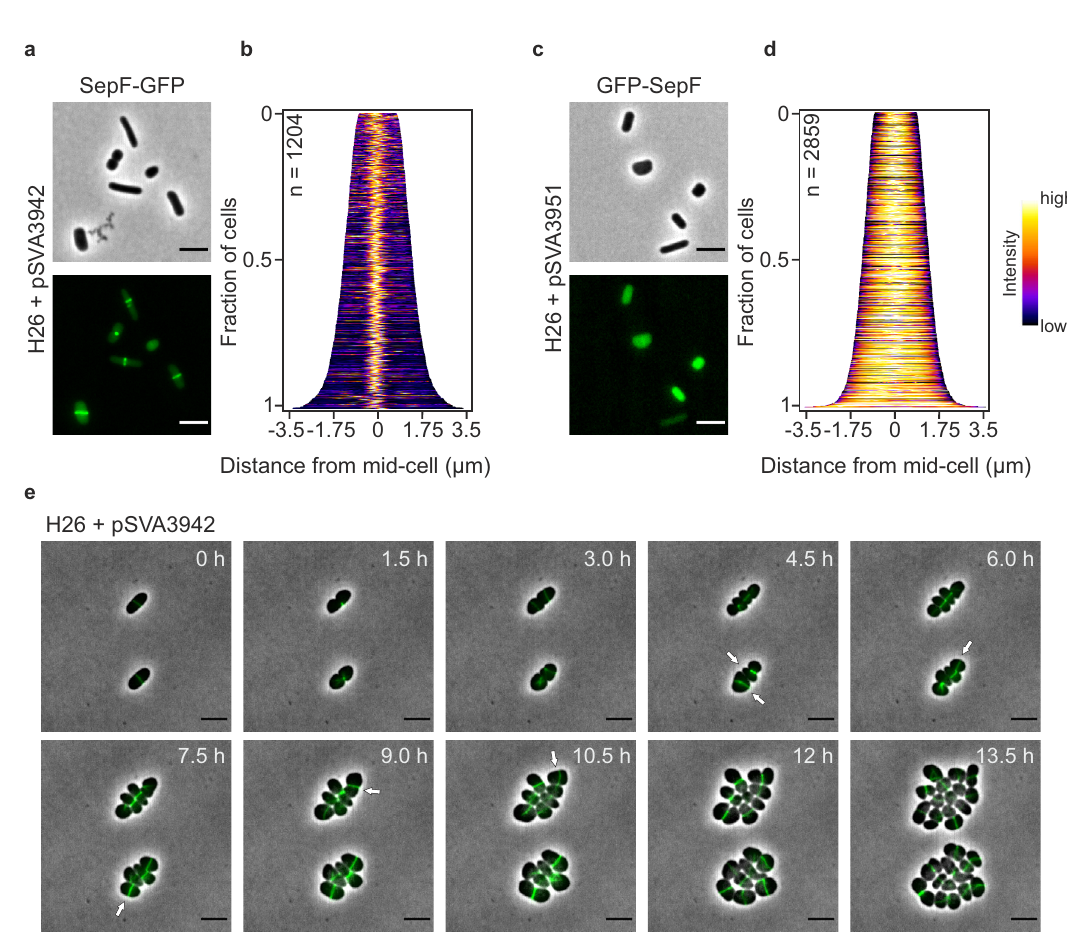
Fig. 1 Localization and dynamic of SepF from H. volcanii . a Fluorescence microscopy of SepF-GFP expressing cells during early exponential growth. b Demographic analysis of the GFP signal in the imaged cells shows localization of SepF in the cell center independent of the cell length in all cells. c Fluorescence microscopy of GFP-SepF expressing cells during early exponential growth. d Demographic analysis of the GFP signal in the imaged cells shows the diffuse signal of SepF throughout the cells independent of the cell length. Demographs were based on the GFP signals of cells imaged in three independent experiments. e Time-lapse microscopy of SepF-GFP expressing cells. Cells were grown on an agarose nutrition pad in a thermo-microscope set to 45 °C and imaged every 30 min. The selected pictures show constricting SepF rings during cell division. The new cell division plane in the daughter cells often occurs perpendicular to the old one (indicated by white arrows). The experiment was repeated three times independently with similar results. Scale bars: 4 µ